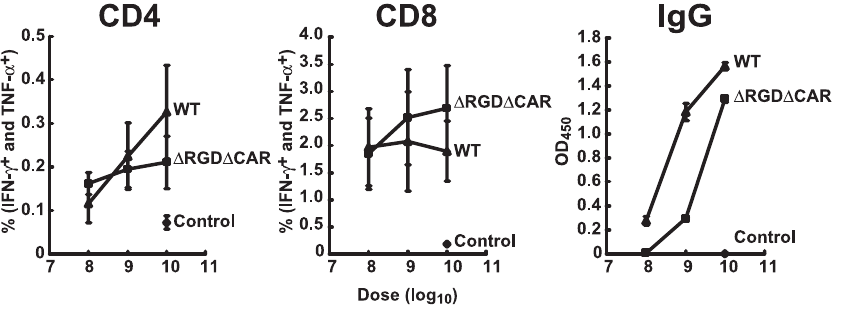
Figure 3. Immunogenicity of WT and Mutant rAd Vectors Dose-response analysis of WT or CAR (cid:2) RGD (cid:2) mutant rAd immunogenicity in vivo. Cellular (CD4, CD8) and humoral (IgG) immune function was analyzed at the indicated doses of rAd vector. Spleen cells were stimulated with GFP peptides or Ebola virus glycoprotein (EB peptides) as the negative control, or peptide dissolving solvent as background control, and stained for the indicated cell surface markers and intracellular cytokines using fluorochrome- conjugated monoclonal antibodies. The percentage of intracellular IFN- c þ (IFN- c -FITC) and TNF- a þ cells in total CD4 þ or CD8 þ in GFP peptide-stimulated samples was subtracted from the background control samples (no peptide stimulation). The samples were also stimulated with an irrelevant peptide pool derived from Ebola virus glycoprotein (Figure S2). The average of data from five mice in each group and the standard deviations are shown. For CD4 þ and CD8 þ responses, at each dosage, there is no significant difference between WT and the mutant ( p . 0.05, t -test by Microsoft Excel). Mouse sera were diluted at 1:100, and anti-GFP IgG was measured by ELISA. The averages of five mouse sera in each group with standard deviations are presented. Mutant generated less IgG response compared with WT at each dosage ( p , 0.05, t -test by Microsoft Excel).